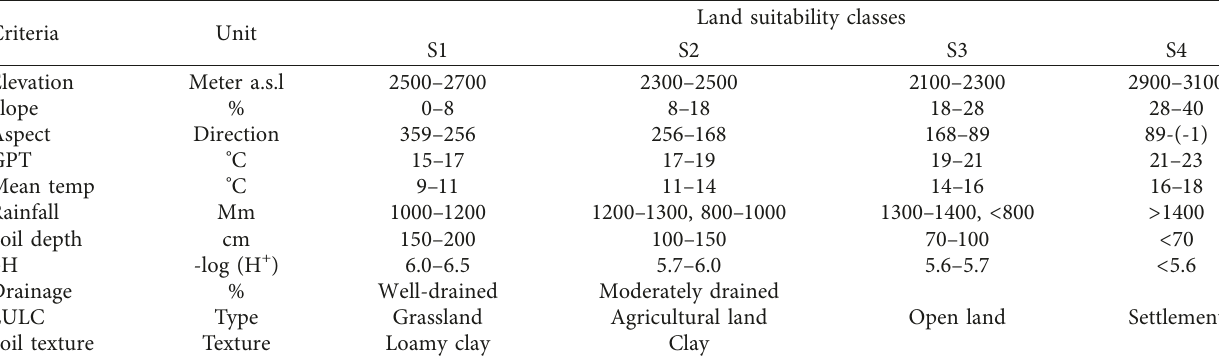
Table 4: Land suitability criteria classification for apple cultivation [8, 9,